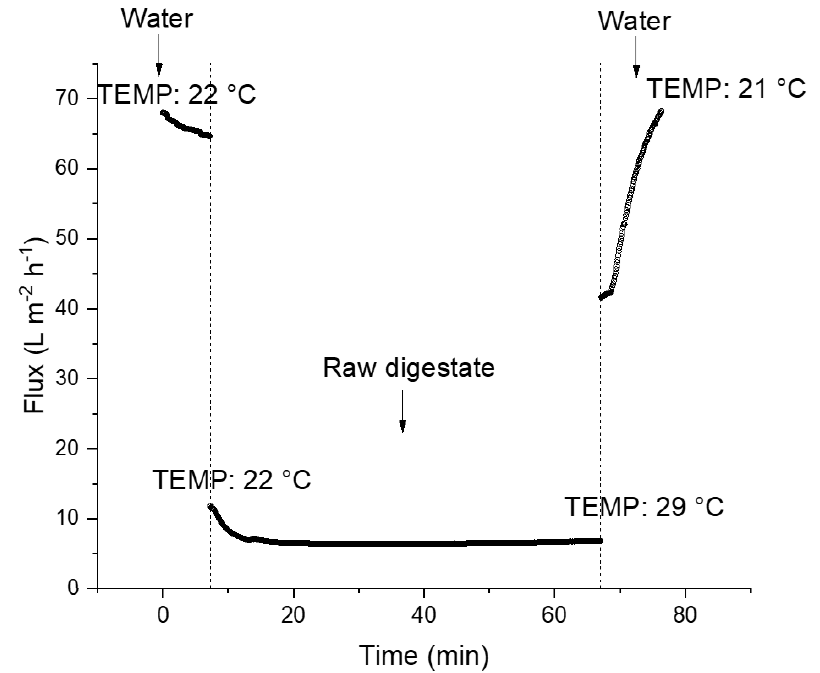
Figure 8. Permeate flux variation using a commercial crossflow membrane plant fitted with the KOCH ABCOR ® tubular membrane (system operated at 0.5 bar; fluid temperature is shown as TEMP). The three sections from left to right are: pre-flushing with water, introduction of raw digestate and post-filtration washing with water.